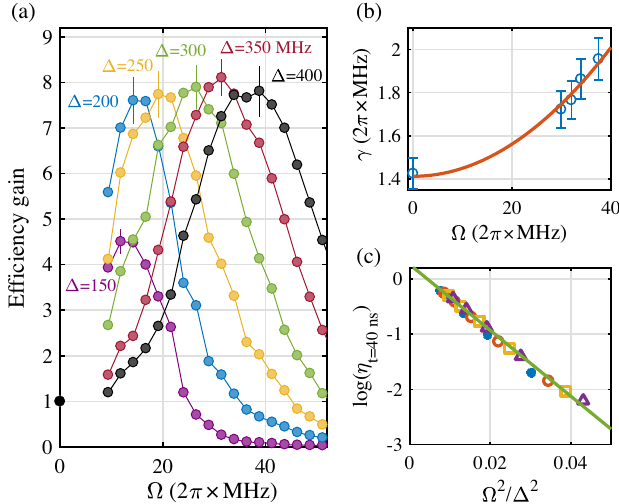
FIG. 6. Efficiency enhancement and loss with a dressing field at intermediate detunings. (a) Gain in efficiency at a long storage time ( t ¼ 250 ns) with double-dressing protection as a function of dressing Rabi frequency Ω . Solid lines are a guide to the eye. The gain saturates due to a slight increase in homogeneous decoherence at large dressing powers. (b) Added homogeneous decoherence rate γ for several dressing Rabi frequencies Ω at detuning Δ ¼ 2 π × 350 MHz. The solid line is a fit to a quadratic model. (c) Efficiency loss at a short storage time ( t ¼ 40 ns) for different powers (marked as different markers) and for several detunings. All data sets collapse when plotted against Ω 2 = Δ 2 and fit well to the scattering model γ ¼ γ 0 þ ΓΩ 2 = Δ 2 across a wide range of the parameter Ω = Δ